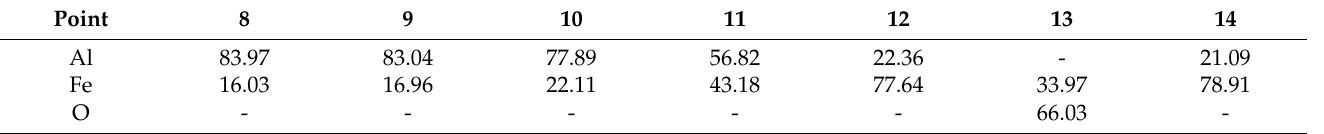
Figure 10. SEM micrograph of the joining zone between steel and layer II: ( a ) position A, ( b ) posi- tion B. Table 4. The element composition of points 8 to 14 in the joint zone by EDS spectrum analysis (at %).